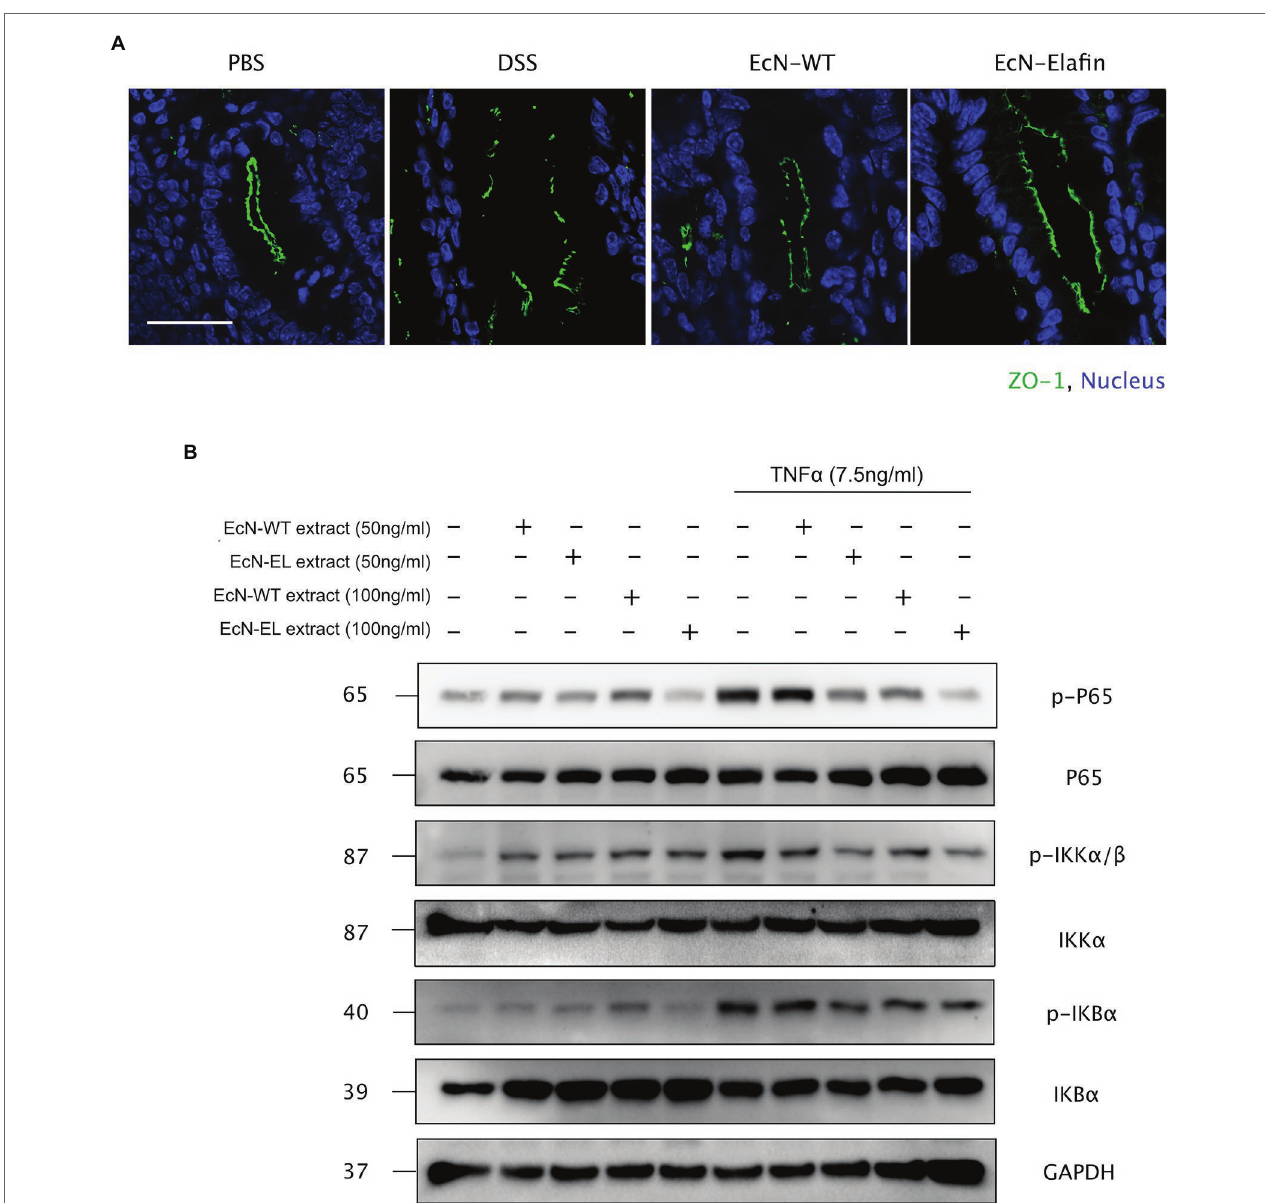
FIGURE 3 | EcN-Elafin enhanced the intestinal epithelial barrier in mice with colitis. (A) Representative photo of immunofluorescence staining for the epithelial tight junction protein ZO-1 in mouse colonic tissues. Scale bar = 20 μ m. (B) Caco-2 cells were cultured and then stimulated with recombinant TNF- α (7.5 ng/ml) in the presence or absence of either EcN-WT or EcN-Elafin bacterial extracts for 30 min. Then, the cell lysates were analyzed for p-I κ B α , I κ B α , p-IKK β , IKK β , p-P65, P65, and GAPDH expression by Western